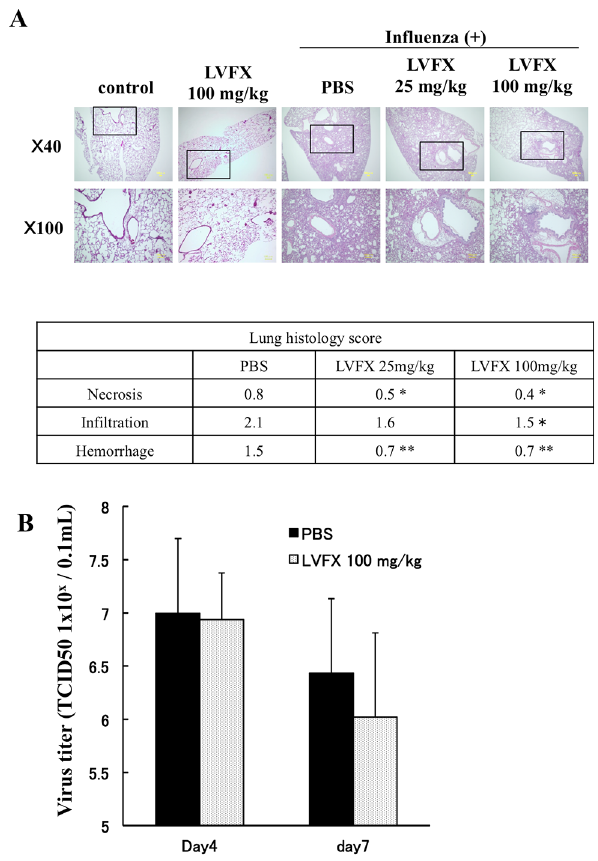
Fig 3. The effect of LVFX on lung damage and viral titer in influenza virus-infected mice. (A) Section of lung tissue were prepared at the day 7 after influenza virus infection, and subjected to histopathological examination with HE staining (upper). The alveolar space was observed in lungs from control mice, however the influenza virus infection caused a marked increase in the infiltration of inflammatory cells into the alveoli or peribronchial areas, and the alveolar space was completely filled with these cells. Treatment with LVFX at a dose of 100 mg/kg decreased the overall infiltration of inflammatory cells. The histopathological severity of lung section was determined and average score showed in lower of HE staining image. Histological score shown PBS (n = 4), 25 mg/kg LVFX (n = 5) and 100 mg/kg LVFX (n = 5). (B) The effect of LVFX on viral load at day 4 and 7 were determined using a plaque forming assay. Each bar represents the mean ± SD (n = 3 – 5). * p < 0.05, ** p < 0.01 vs PBS.